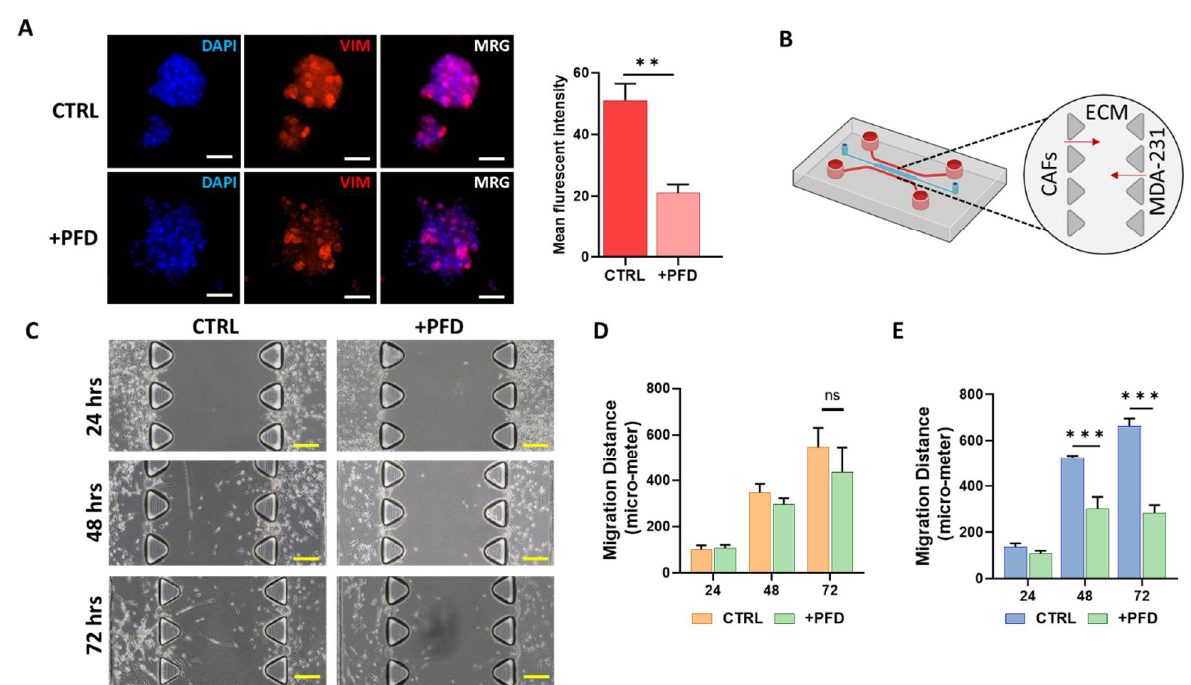
Figure 4. Assessing the migration and invasion inhibitory effects of PFD on MDA-MB-231 carcinoma cells and CAFs. ( A ) Tumor spheroids derived from MDA-MB-231 show a significant reduction in the expression of EMT marker VIM (scale bar: 100 µm). ( B ) The schematic image of invasion and migration assay performed in the 3D microfluidic device in which MDA-MB-231 and CAFs are injected in side channels. The migration of cells was monitored for three days after seeding. ( C ) A representative bright-field image of migration of CAFs and MDA-MB-231 in the presence and absence of PFD highlight that PFD significantly suppressed the migration of both cells during 72 h. (scale bar: 200 µm) ( D , E ) The quantitative analysis of migration distance for CAFs ( D ) and MDA-MB-231 cells ( E ) indicated that PFD did not significantly suppress the migration of CAFs after 72 h; however, in comparison with the control group, a reduction was observed. In the case of MDA-MB-231 cells, PFD significantly suppressed the invasion and migration of these cells after 48 and 72 h. ** p < 0.002 using the Student t -test, *** p < 0.0002 using ANOVA.